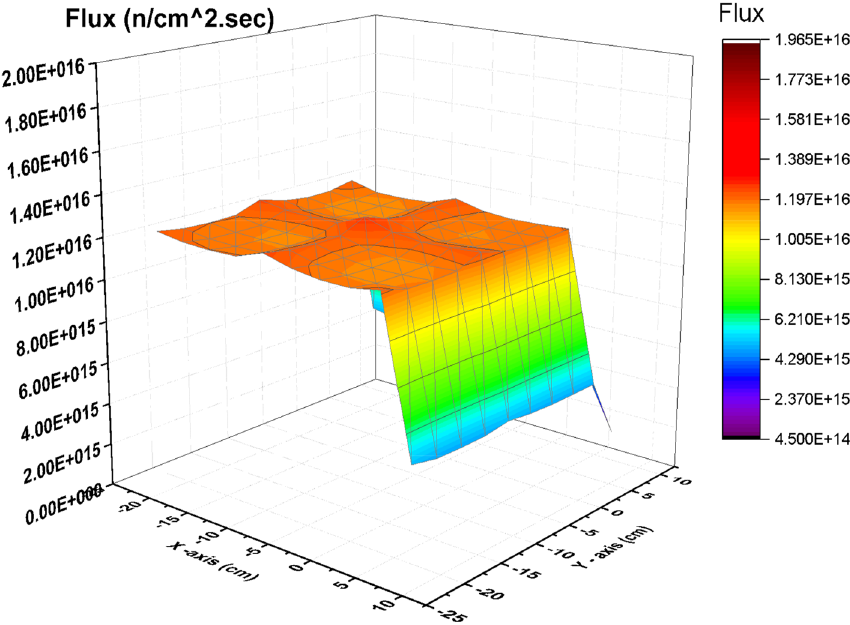
Figure 9. Total flux distribution for the four bundle using 10 meshes in case of C in the control blade .